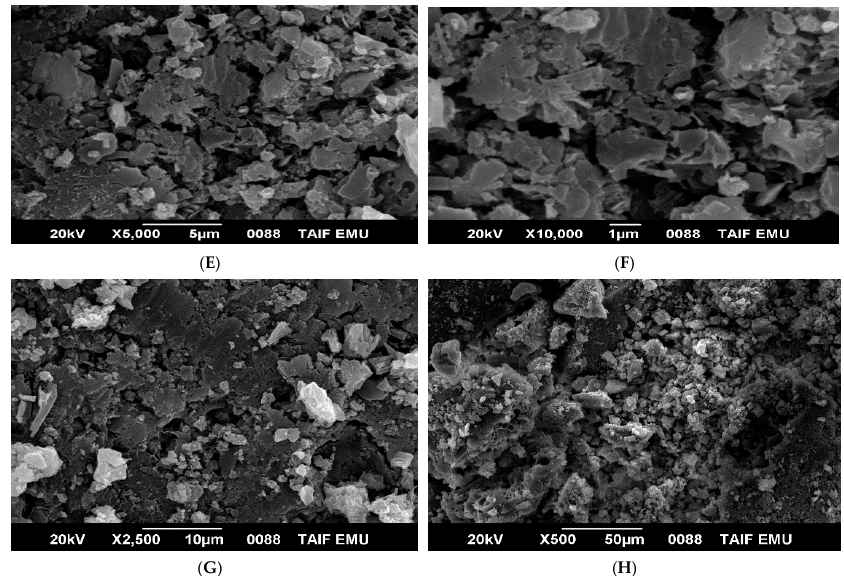
Figure 4. SEM images at a different magnification of ( A – D ) AMT and ( E – H ) Cu(II)-AMT.